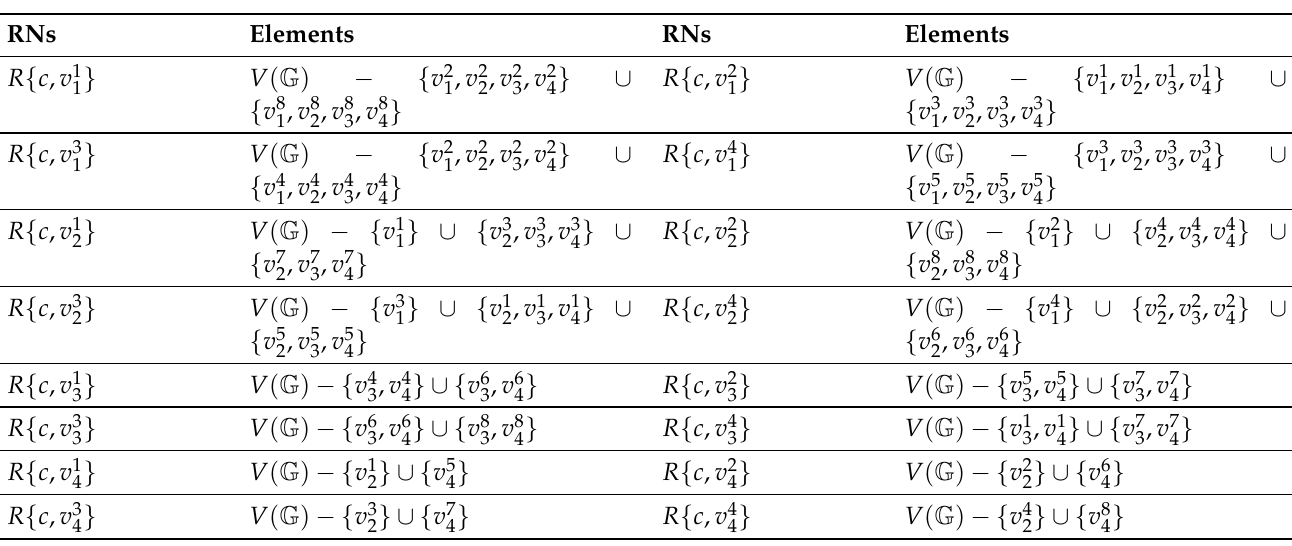
Table 16. RNs ´ R u for 61 ≤ u ≤ 77.